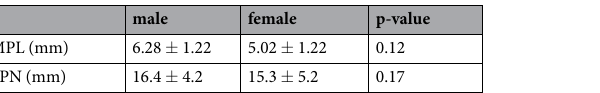
Table 1. Comparison between the genders (male = 19; female = 15) MPN = medial plantar nerve LPN = lateral plantar nerve The p-values were determined using independent sample t-tests. Significance levels are indicated by p < 0.05.